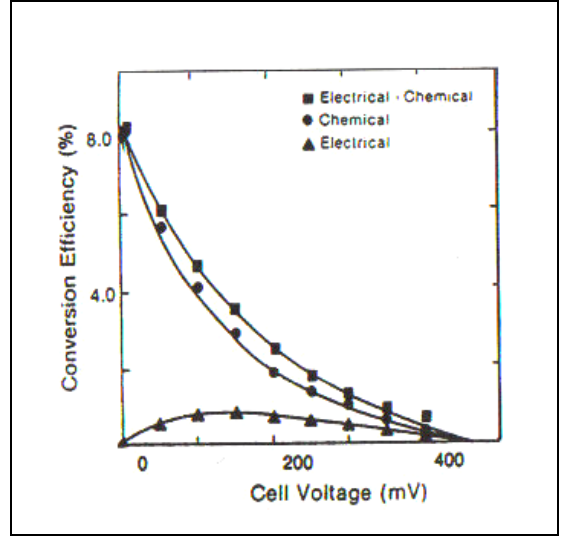
-coated n -GaAas electrodes 2